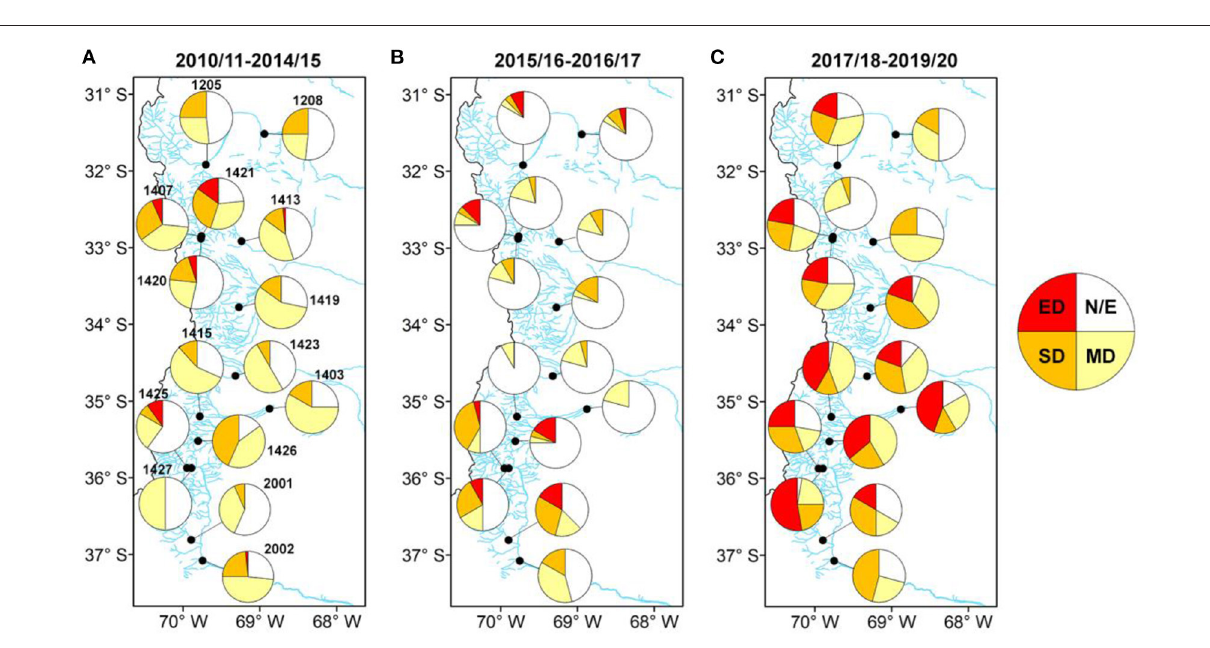
FIGURE 9 | Pie charts showing the proportion of months (expressed as percentage) under the categories determined by the SSI3 time series for each of the 15 analyzed rives over CWA during three sub-periods: 2010/11-2014/15 (A) , 2015/16-2016/17 (B), and 2017/18-2019/20 (C) . Yellow, orange and red colors indicate moderate, severe and extreme hydrological drought conditions (MD, SD, and ED), respectively; white color indicates normal/excess (N/E) conditions. Panel A shows the number of each streamflow